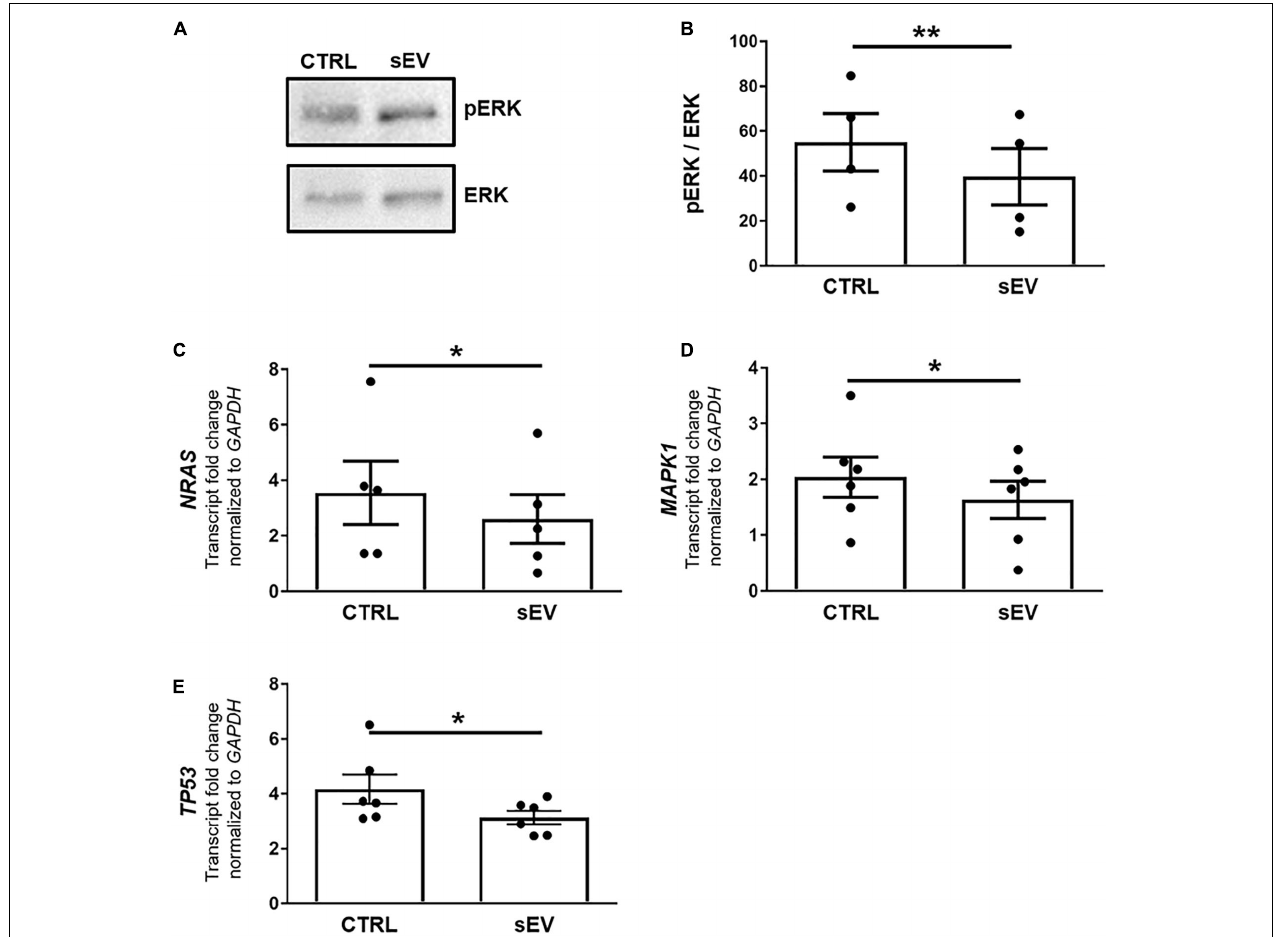
FIGURE 3 | WJ-MSC-derived sEV drive oligodendrocyte maturation in MO3.13 cells by reducing MAPK/ERK signaling. (A) Representative western blot of ERK and phosphorylated ERK (pERK) levels in MO3.13 cells either left untreated or co-cultured with 0.5 µ g/mL sEV for 5 days. (B) Quantification of the ERK/pERK ratio of n = 4 replicates. (C–E) Transcription of NRAS ( n = 5), MAPK1 ( n = 6), and TP53 ( n = 6) by MO3.13 cells either left untreated or co-cultured with 0.5 µ g/mL sEV for 5 days. Data are presented as mean ± SEM. * p < 0.05, ** p <